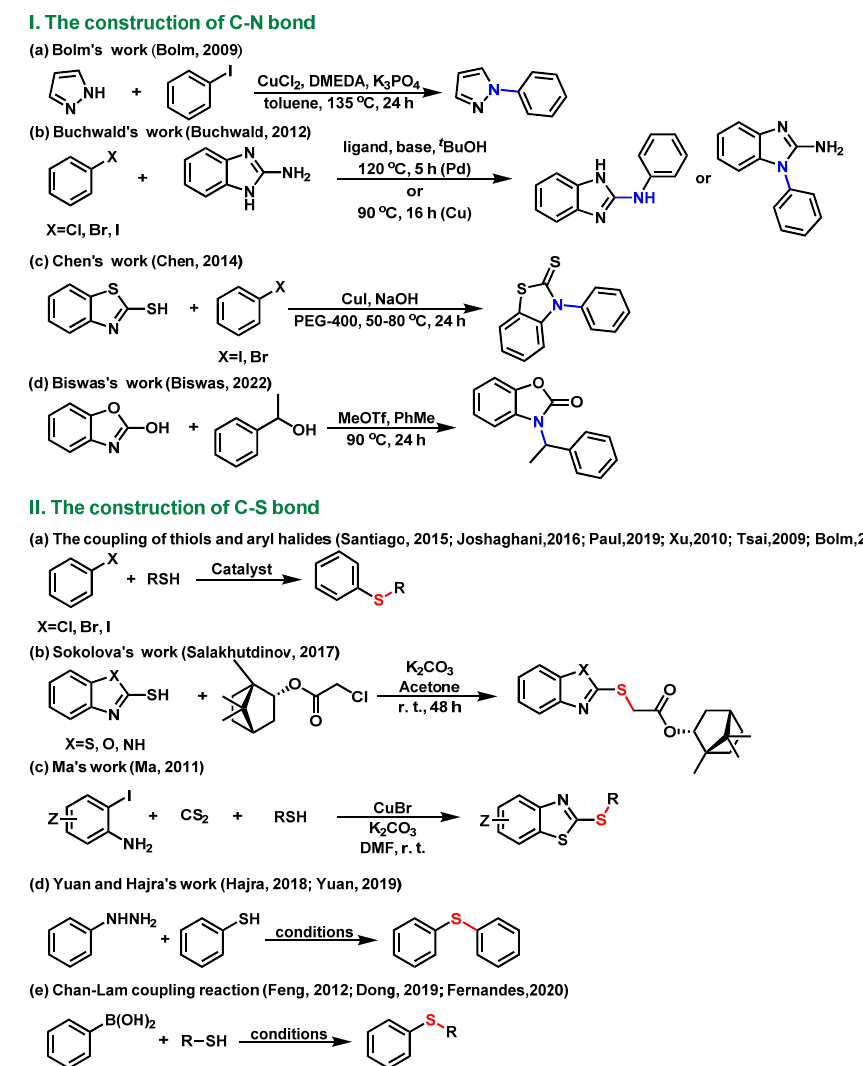
Figure 1. Representative biologically active compounds containing C-N/C-S